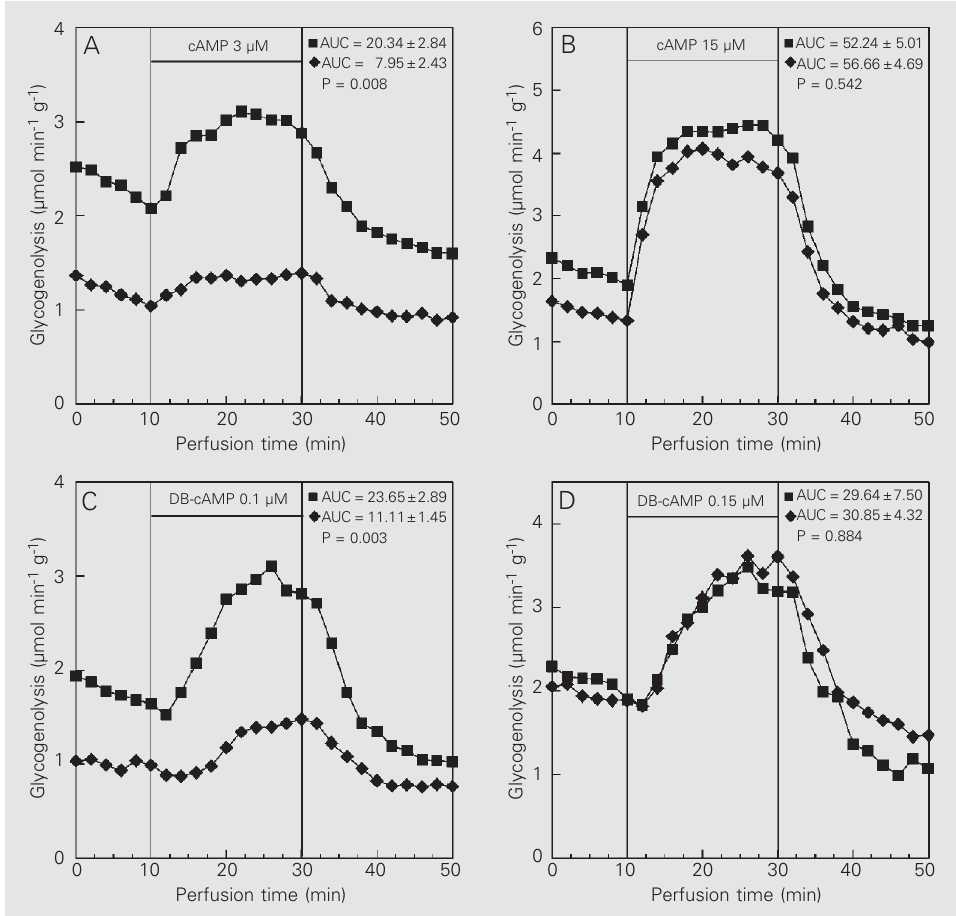
Figure 1. Effect of adenosine- 3'-5'-cyclic monophosphate (cAMP) (panels A and B) and dibutyryl cAMP (DB-cAMP) (pan- els C and D) on glycogenolysis. The data are reported as the means of 4-6 perfused livers ob- tained from rats killed 60 min after the injection of saline (con- trol, squares) or insulin (1 IU/kg, lozenges). The area under the curve (AUC) data (µmol/g liver fresh weight ± SEM) are pre- sented in the figure. The statisti- cal test used was the unpaired Student t